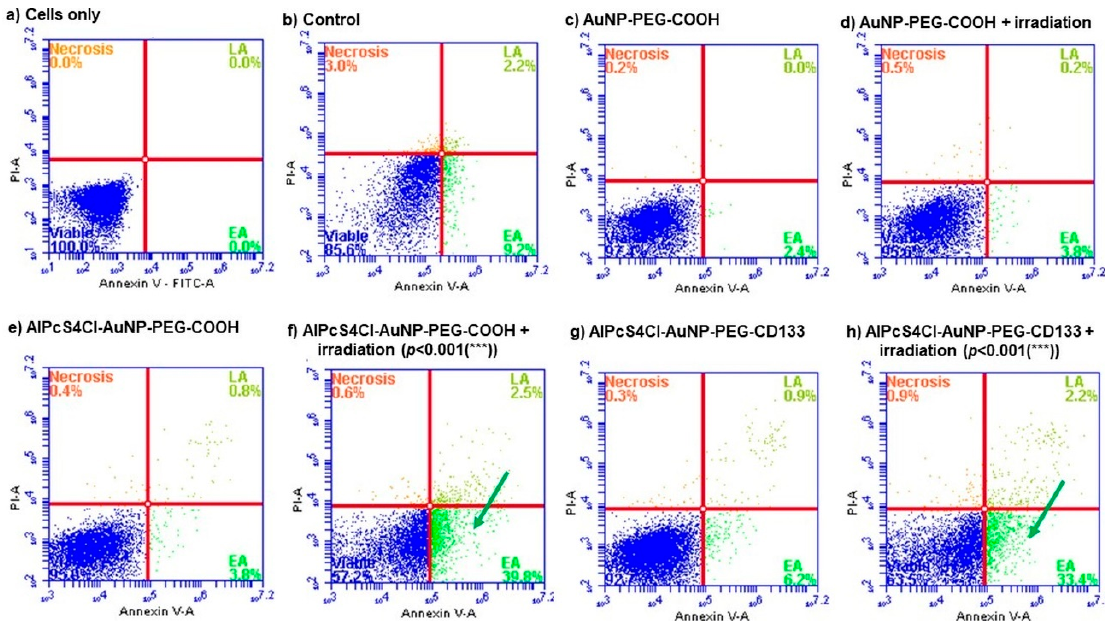
Figure 9. Annexin VPI cell death analysis of Lung CSCs 24 h post-irradiation. ( a ) Unstained cells were used to establish the cell population. ( b ) Cells receiving no treatment were used as the control. ( c )